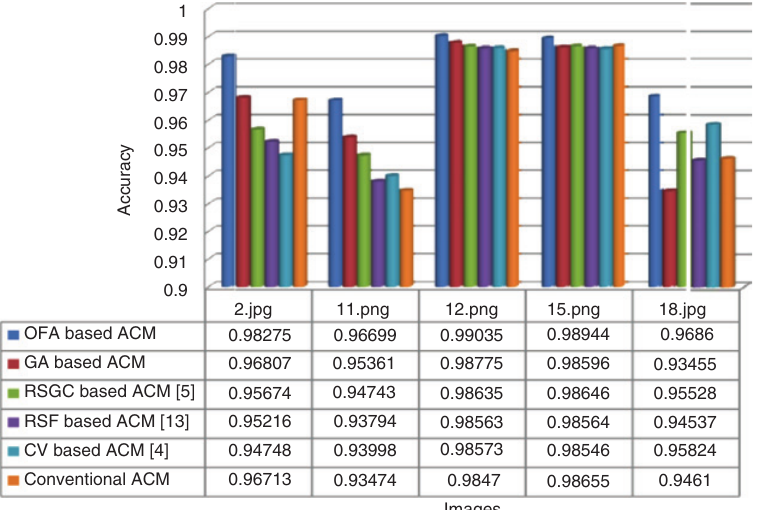
Figure 5: The Accuracy Comparison between the Proposed OFA-based ACM, GA-based ACM, RSGC, RSF, CV, and conventional ACM.